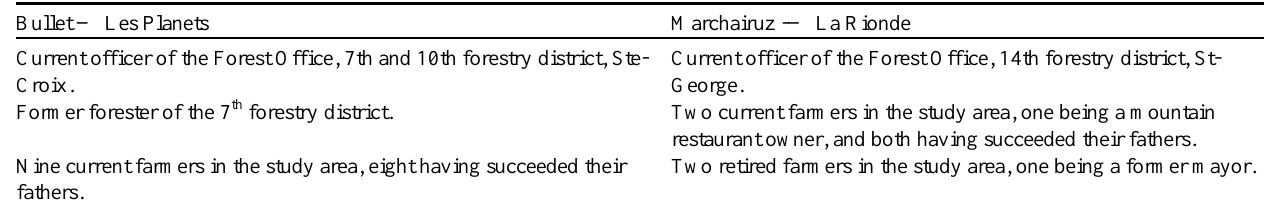
Table 2 . List of the persons interviewed for the project. Bullet — Les